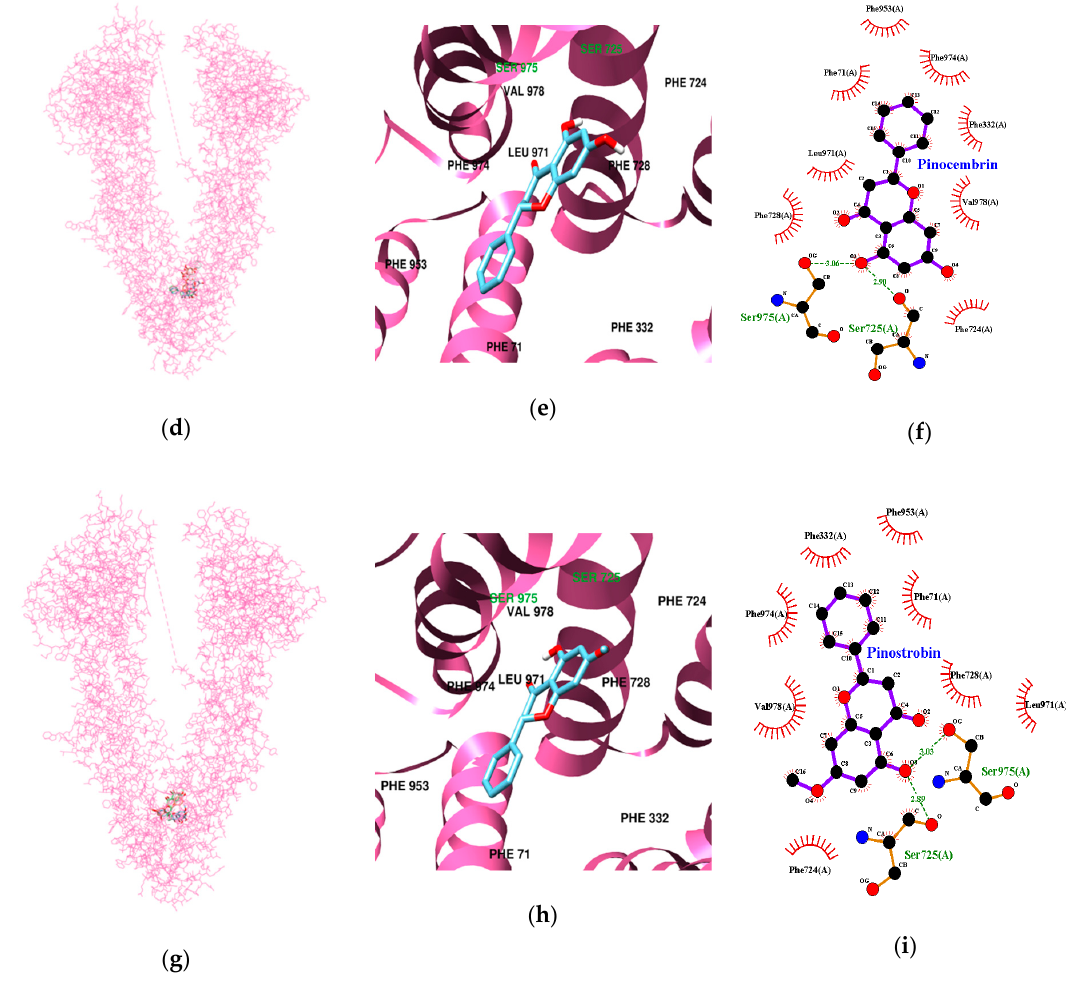
Figure 4. Molecular docking analysis of cardamonin, pinocembrin, and pinostrobin with P-gp. The best docking poses between P-gp and cardamonin ( a ), pinocembrin ( d ), and pinostrobin ( g ). Magnified view of the binding site for cardamonin ( b ), pinocembrin ( e ), and pinostrobin ( h ). Hydrogen and hydrophobic interaction diagram of cardamonin ( c ), pinocembrin ( f ), and pinostrobin ( i ). The green dotted lines show hydrogen bonds between ligands and BACE1.